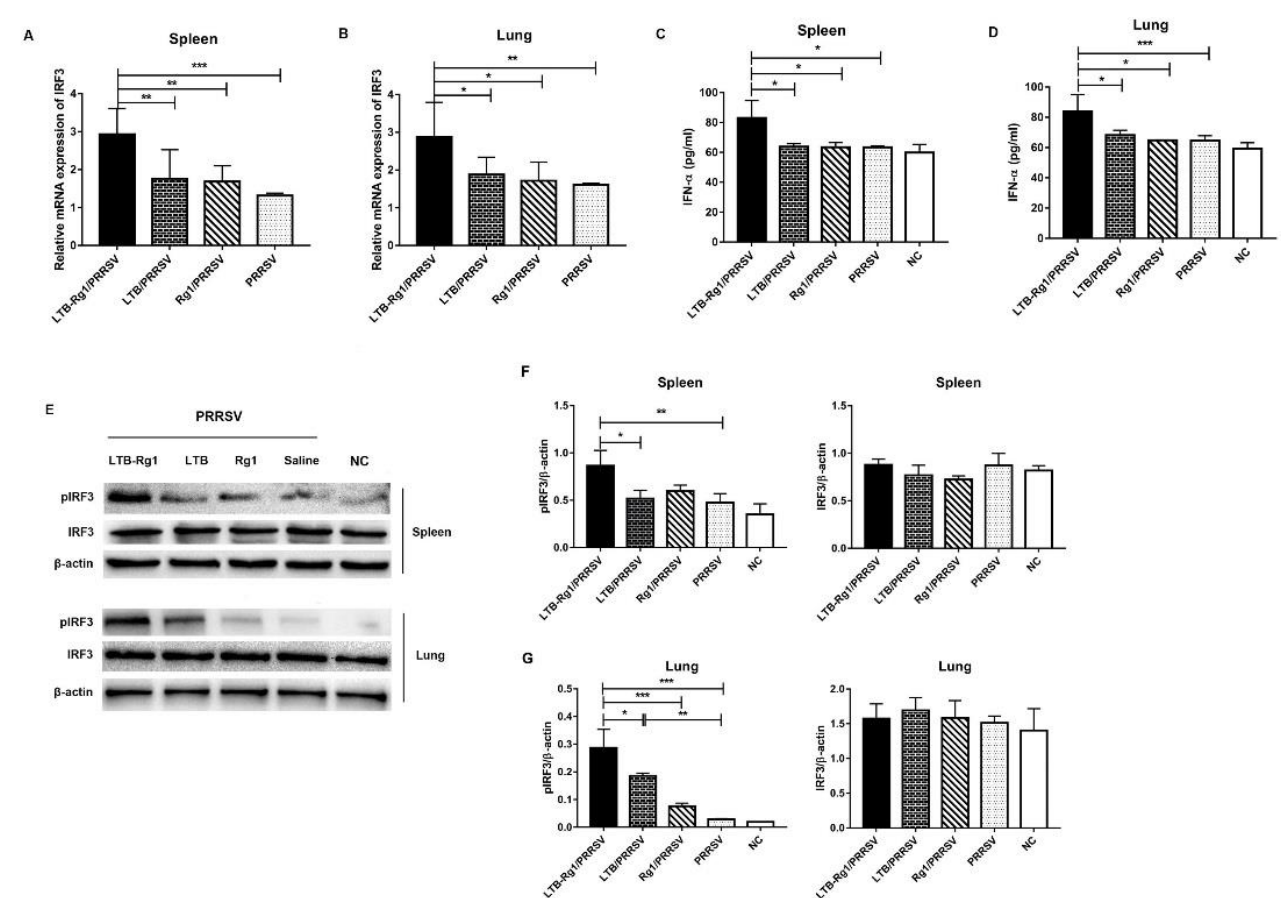
Figure 9. LTB-Rg1 up-regulated type I interferon signaling pathway. Mice ( n = 6/group) were immunized intranasally with PRRSV vaccine admixed with either saline, LTB, Rg1, or LTB-Rg1. On day 35, splenocytes and lung mononuclear cells were collected. ( A , B ) One aliquot each of splenocytes and lung mononuclear cells was re-stimulated with PRRSV antigen for 24 h and tested for interferon regulatory factor (IRF) 3 mRNA expression by qPCR. ( C , D ) The remaining spleen and lung cells were re-stimulated with PRRSV antigen for 72 h and tested for IFN- α quantification in the supernatant by ELISA. ( E ) Cell lysis was analyzed for phosphorylation of IRF3 by Western blot. ( F , G ) The intensity ratios of pIRF3 and IRF3 bands normalized by β -actin in spleen and lung tissues. Data are expressed as means ± SD. * p < 0.05, ** p < 0.01, *** p < 0.001.